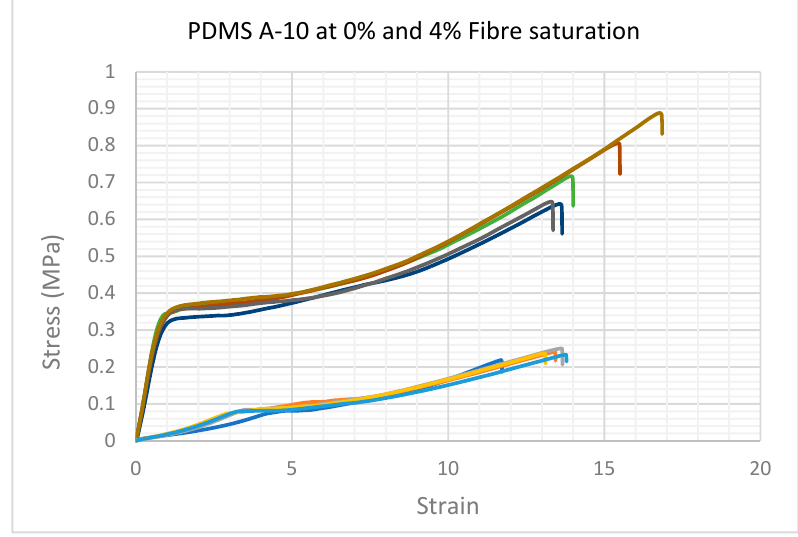
Figure 5. An example of the comparative stress/strain curves derived from recorded specimen data. The lower group of vectors in this graph show the A-10 group with 0% fibres. The stress / strain curves are typical of Hookean elastomers, lacking fibres this group exhibited minimal signs of viscoelastic